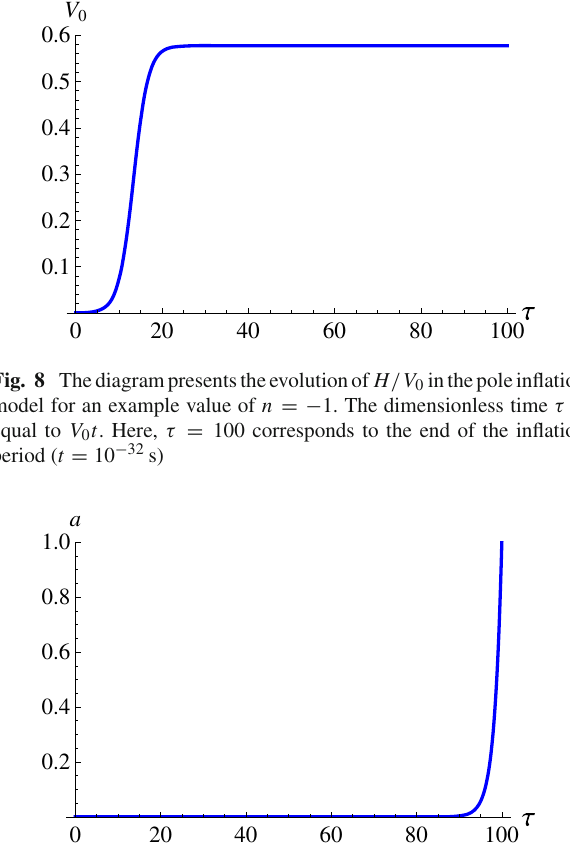
Fig. 9 The diagram presents the evolution of the scale factor in the pole inflation model for an example value n = − 1. The dimensionless time τ is equal to V 0 t . Here, τ = 100 corresponds to the end of the inflation period ( t = 10 − 32